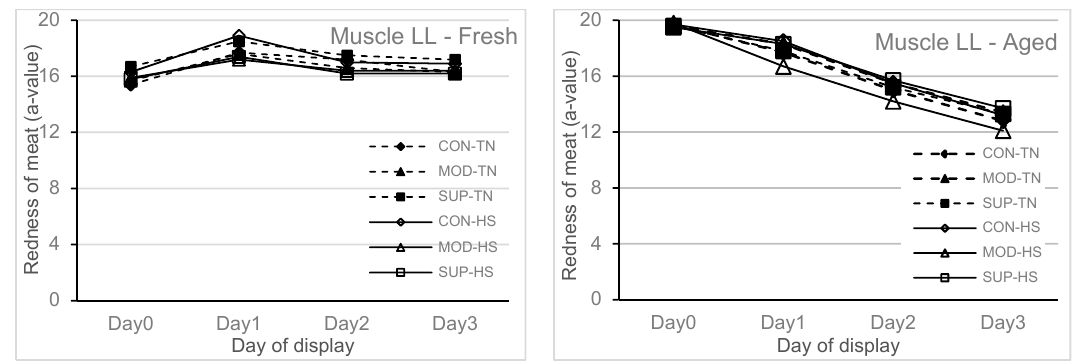
Figure 1. Lipid oxidation (malondialdehyde (MDA), mg/kg meat) in fresh and aged (packaged and stored for 42 days at 2 °C refrigerated condition) lamb meat (muscle longissimus lumborum (LL)) at 1 h (Day 0) and 72 h (Day 3) of simulated retail display. Lambs were finished on four weeks of experimental diets 1 followed by one week thermal treatment 2 . 1 Control (CON) = lambs supplemented Vit E @ 28 mg/kg DM and Se @ 0.16 mg/kg DM; moderate (MOD) = lambs supplemented Vit E 130 mg/kg DM and Se @ 0.66 mg/kg DM; supranutritional (SUP) = lambs supplemented Vit E @ 227.5 mg/kg DM and Se @ 1.16 mg/kg DM. 2 Thermal treatment = lambs housed in either a thermoneutral (TN) room with temperature ranging from 18–21 °C and relative humidity (RH) ranging from 40–50% or a heat stress (HS) room with temperature ranging from 28–40 °C and RH ranging from 30–40%, for one week followed by transportation to the abattoir and a 14 h lairage period.